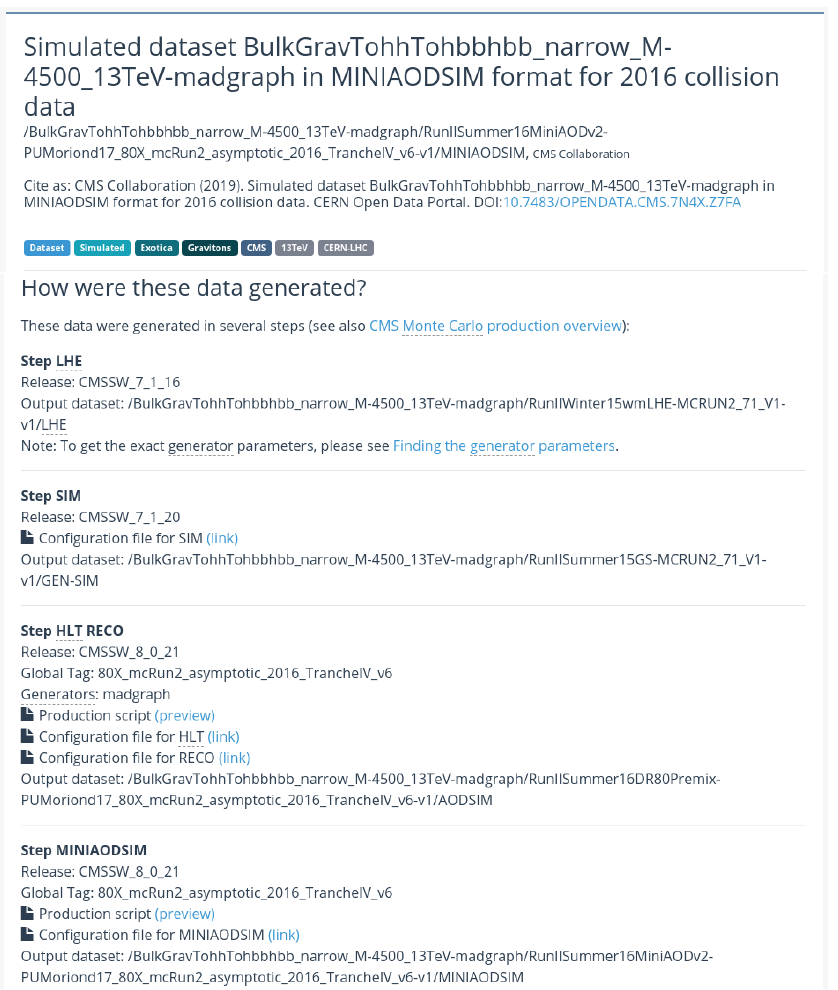
Figure 3. Example of a CMS simulated dataset available on the CERN Open Data portal with detailed provenance information displayed in the “How were these data generated?” section of the